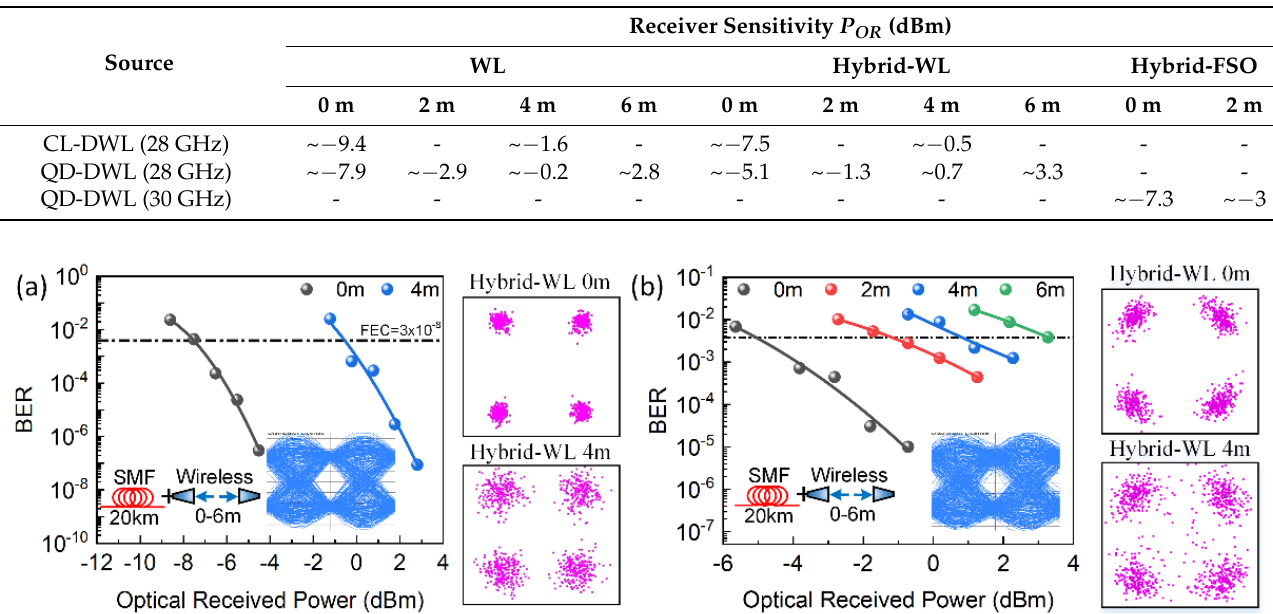
Figure 5. BER versus optical received power of the CL-DWL at 28 GHz ( a ) and QD-DWL at 28 GHz ( b ) for the hybrid-WL channel with various WL sub-link lengths. The respective insets show the received QPSK constellation at a ~0 dBm received optical power for the 0-m (top) and 4-m (bottom) WL link lengths and the eye diagram at a ~0 dBm received power for the 0-m WL link length.